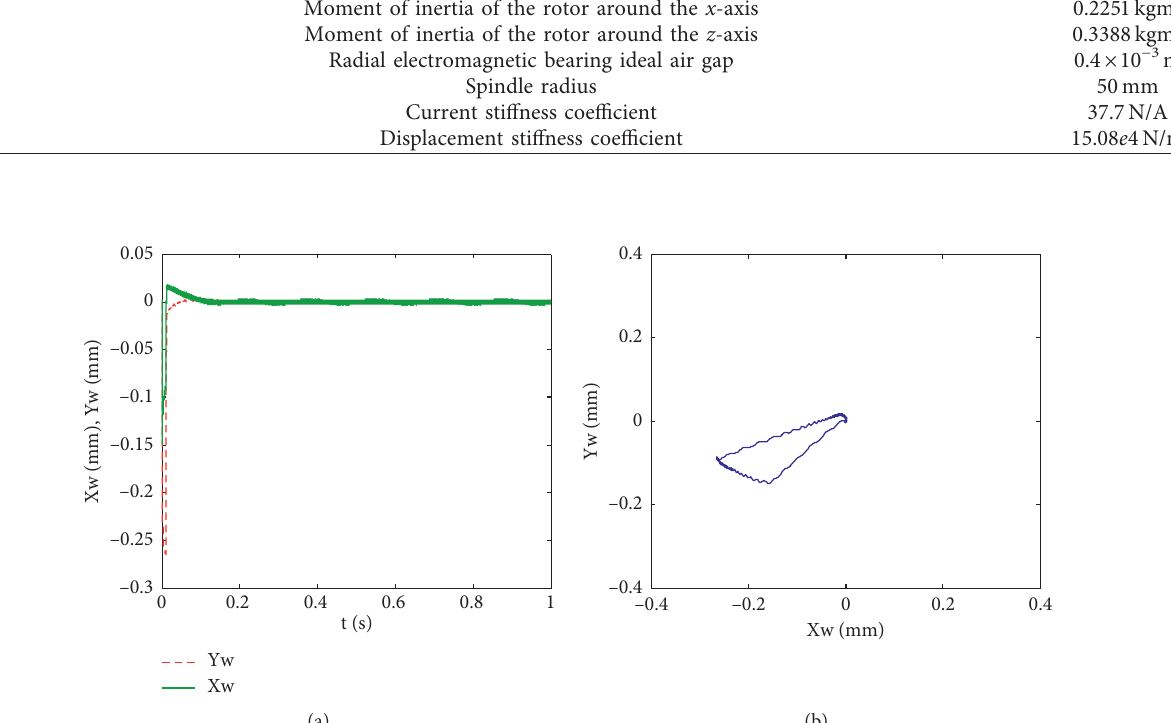
Figure 5: The displacement at the workpiece position based on modal decoupling: stability area of milling (a) without control and (b) with modal decoupling